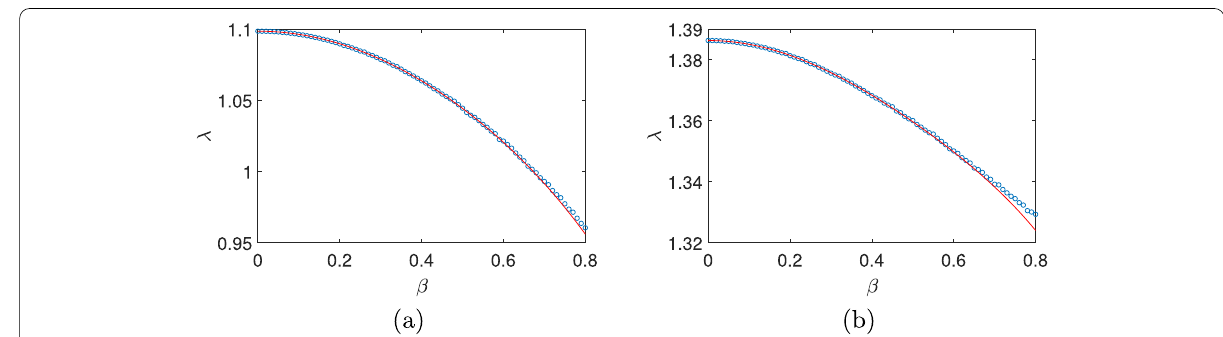
Fig. 4 (Color online) Comparison of the expansion result with the numerical computation for the systems givey by (a) Eq. (43), (b)Eq. (45). The Monte carlo results are marked with (blue) circles while the analytic approximation is plotted with (red) solid